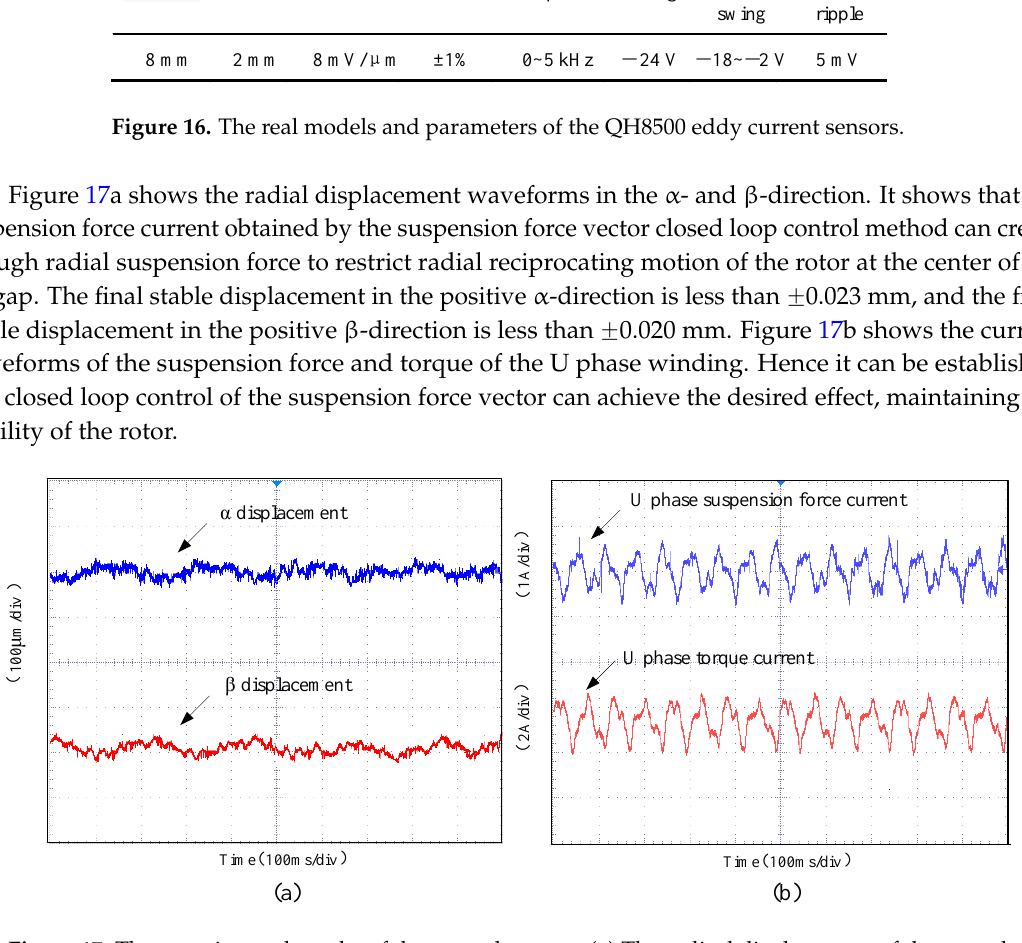
Figure 17. The experimental results of the control system. ( a ) The radical displacement of the α- and β-directions of stable operation; ( b ) The U phase currents of suspension force and torque when the motor rotation speed is 3000 r/min.